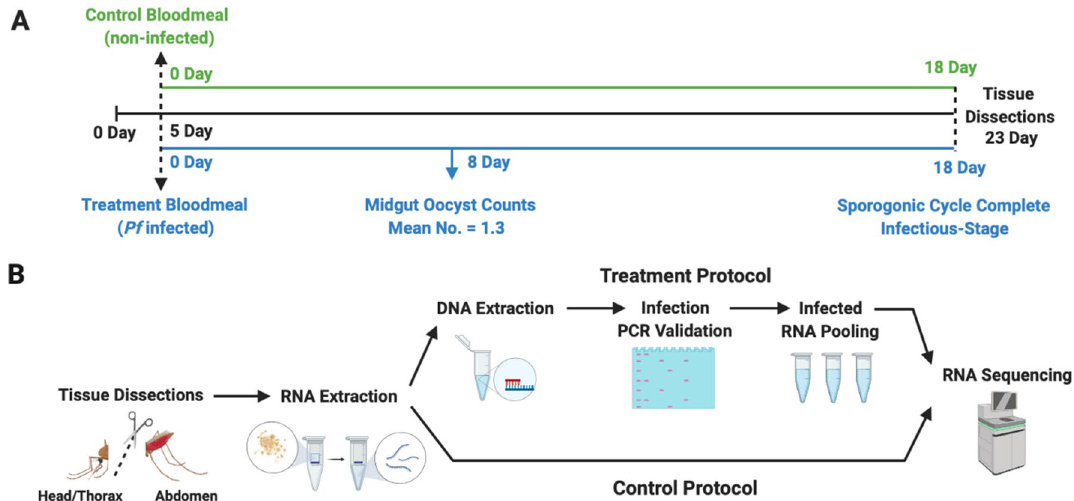
Figure 1. Schematic representation of experimental methodology. ( A ) Timeline for establishment of Plasmodium falciparum sporozoite infected treatment and naive control Anopheles gambiae s.s. mosquito lines. ( B ) Total RNA and gDNA extraction treatment and control protocols for PCR P. falciparum sporozoite infection validation and RNA